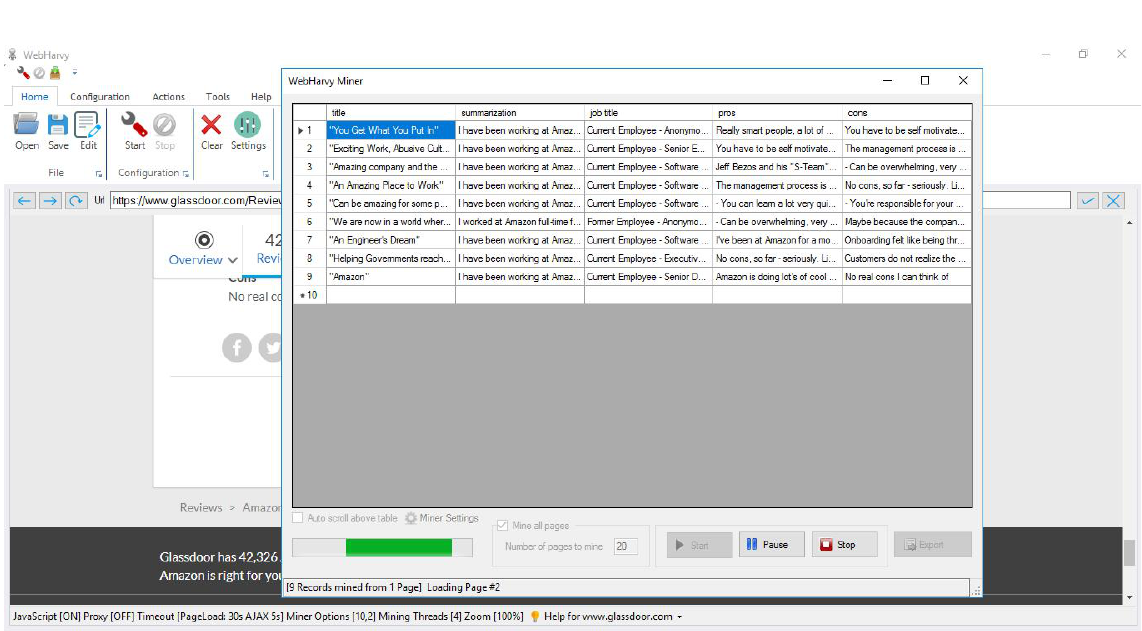
Fig. 3 Crawling the dataset using Webharvy Web